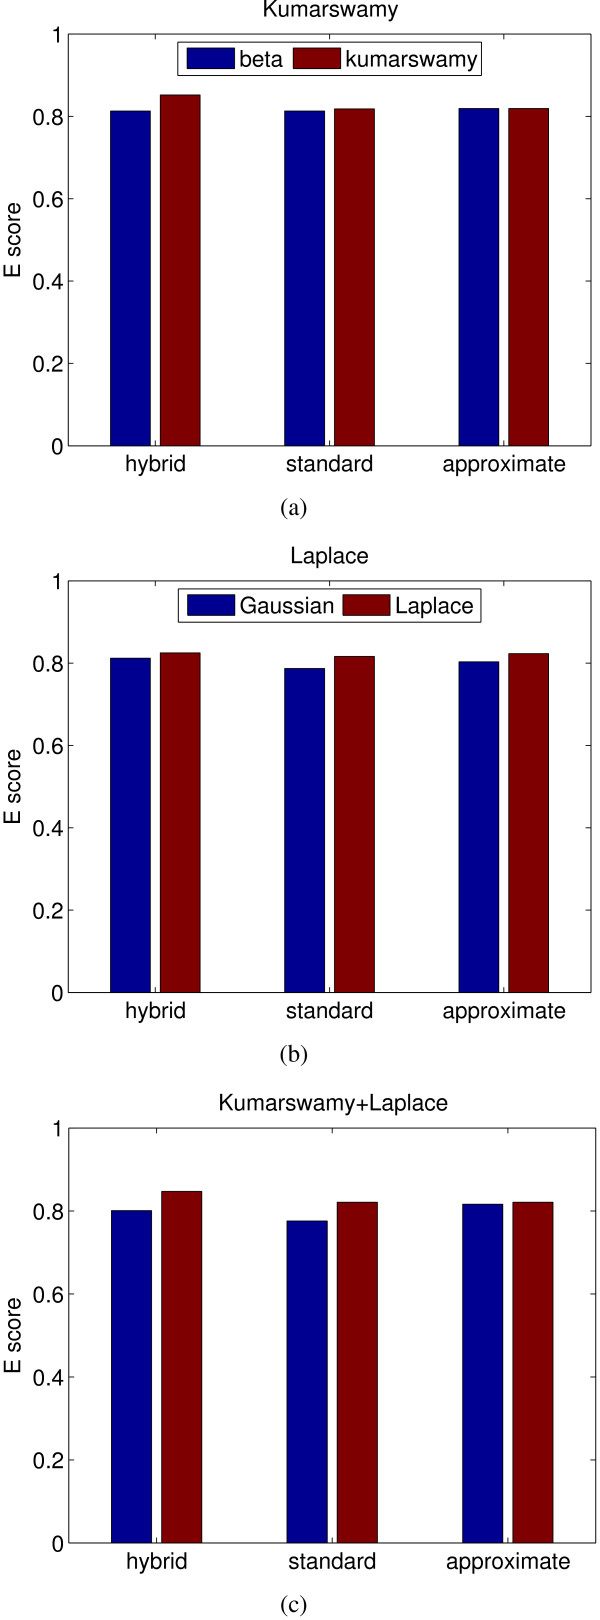
Robustness test of BGMMa, BGMMh and BGMMs. (a) Beta distribution replaced with Kumaraswamy distribution. (b) Gaussian distribution replaced with Laplace distribution. (c) both (a) and (b). x-axis corresponds to the different EM algorithms.